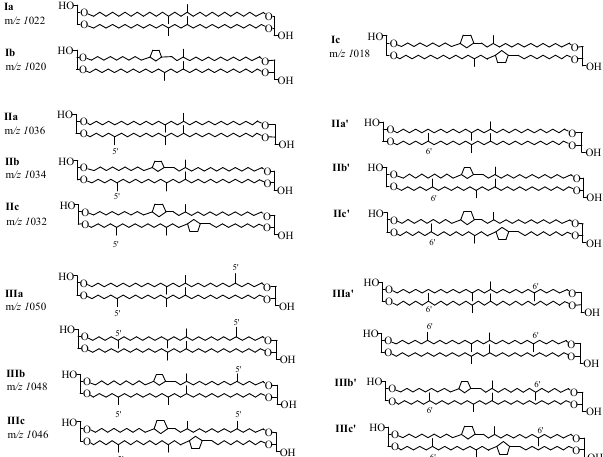
Figure 1. Molecular structures of 5- and 6-methyl branched GDGTs used in this study. The compounds that have one or two methyl groups at the α 6 or ω 6 position are defined as 6-methyl brGDGTs, while the compounds that have one or two methyl groups at the α 5 or ω 5 position are defined as 5-methyl